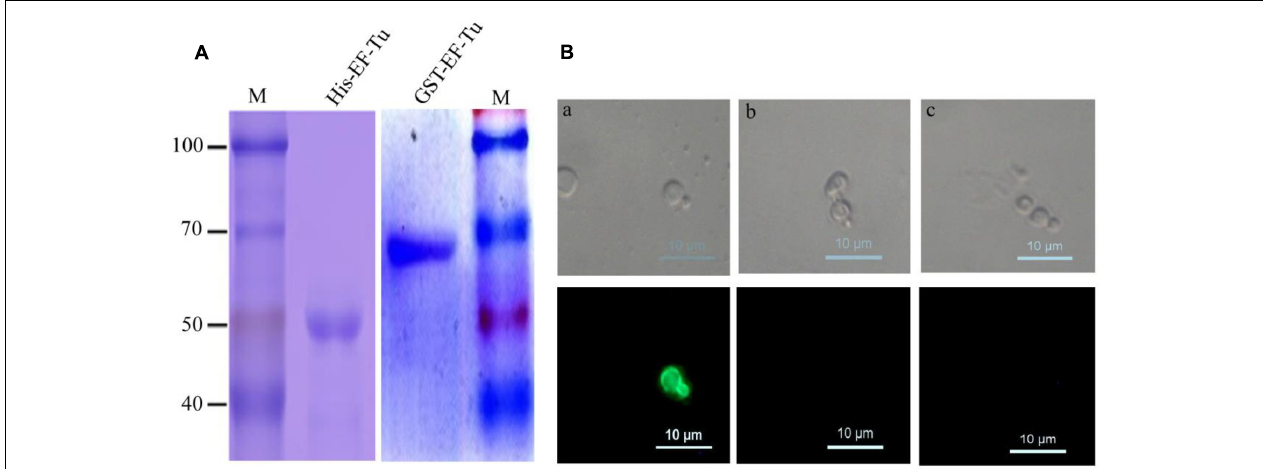
FIGURE 1 | Identified McAbs that recognize EF-Tu protein. (A) SDS–PAGE analysis of purified His-Tag and GST-Tag Brucella melitensis EF-Tu protein. (B) Analysis of specificity of McAb BD 6 by yeast surface displays. (a) Yeast cells displaying B. melitensis EF-Tu protein were immunofluorescently labeled with McAb BD 6 ; (b) yeast cells with empty plasmid were immunofluorescently labeled with McAb BD 6 ; (c) yeast cells displaying B. melitensis EF-Tu protein with anti-EtMIC2 protein McAb as a non-specific binding McAb